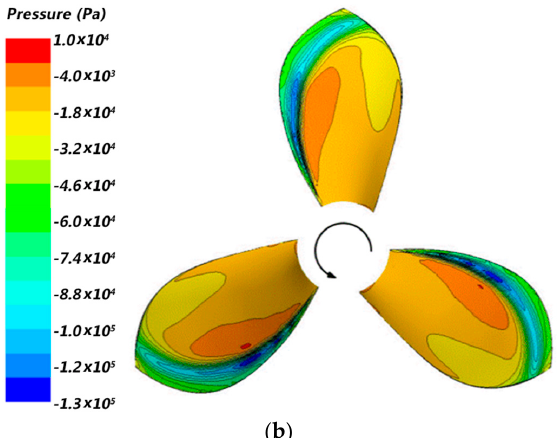
Figure 9. The pressure distribution on the blades at J = 0.85 under ventilated condition. ( a ) The pressure distribution on the pressure surface; ( b ) The pressure distribution on the suction surface. Water 2018 , 10 , x FOR PEER REVIEW Figure 10 plots the pressure distribution at J = 0.85 on various profiles (0.24 R , 0.50 R and 0.70 R ) of the ventilated/unventilated SPP. C p is the pressure coefficient. Blue and red lines refer to the pressure distribution profiles of the unventilated and ventilated SPP, respectively. From Figure 10a one can see that on the profile near the root (0.24 R ), when there is no ventilation, the difference between the pressure on the pressure surface and the one on the suction surface is very large, especially near the leading edge. After ventilating, the pressure on the suction surface of the blade significantly increases and evenly distributes along the entire chord direction. The pressure almost remains unchanged because the air bubbles completely cover the root region of the blades, and in the vicinity of the leading edge ( x / C ≤ 0.1), the pressure on the pressure surface and the suction surface are almost the same. This is because both the pressure surface and suction surface near the leading edge are covered by the air bubble. The same phenomenon can be observed around the trailing edge.